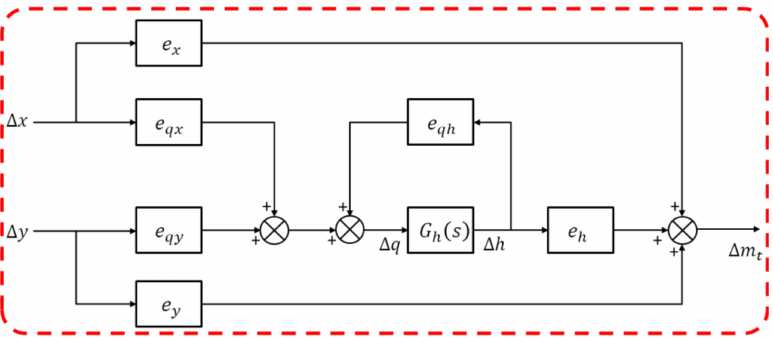
Figure 2. Linearized model of the hydraulic